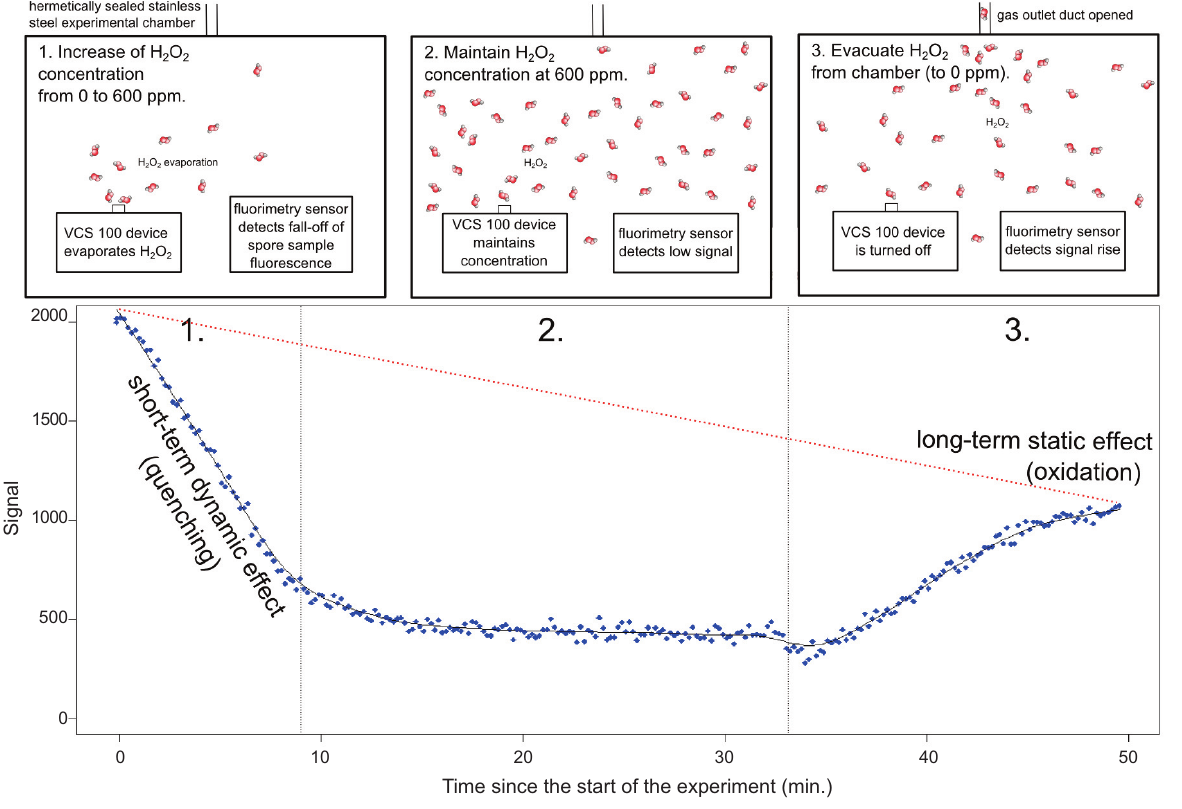
Fig. 3. Three stages of the HPV treatment are shown with relation to the short­term dynamic effect and long­term static effect. At the 1st stage the HPV concentration is increased by the VCS 100 device and the fluorescence signal from bacterial spores falls rapidly (the short­term dynamic effect). At the 2nd stage the HPV concentration stays constant and one can see a slower decrease in the fluorescence signal. At the 3rd stage the HPV concentration returns to zero and the fluorescence signal from spores rises again, but not to the same level at which it was before the experiment. This remaining difference between fluorescence signal before and after the experiment is the long­term static